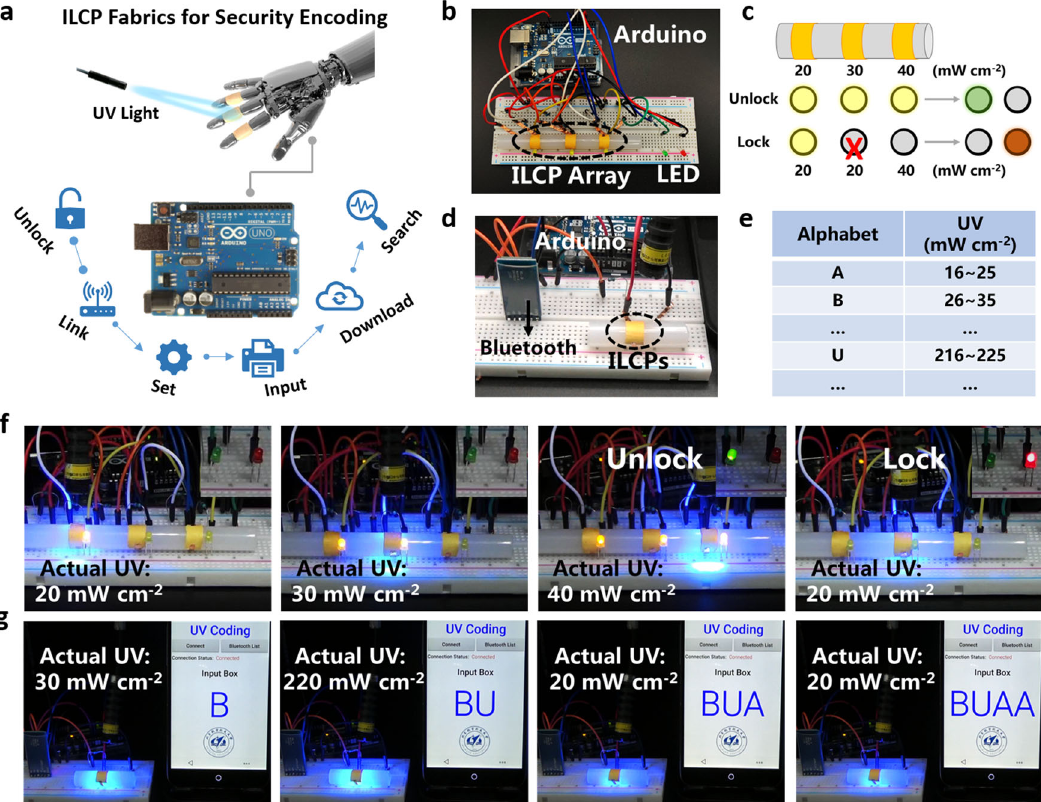
Fig. 4 Applications of UV security encoding. a Schematic illustration of the practical application of ILCP fabrics for security encoding. The decoding of Arduino singlechip can be applied to unlock, link, set, input, download, search, and other communication forms. b The physical connection diagram and c encoding logic of UV security unlock. The right UV illuminance series is “ 20, 30, 40 ” mW cm − 2 . d The physical connection diagram and e encoding logic of UV security input. Photographs of the practical working process of f UV unlock and g UV